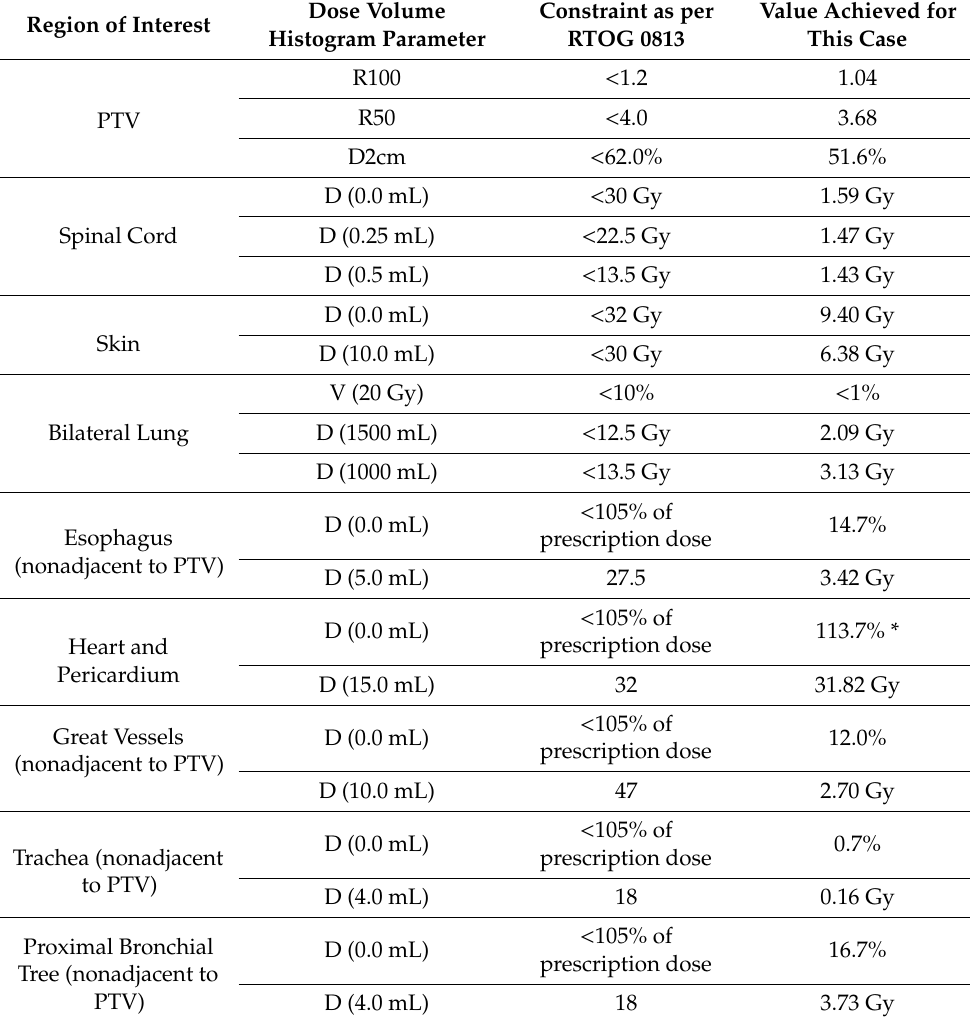
Table 1. Stereotactic body radiation therapy (SBRT) treatment planning dose statistics. Region of Interest